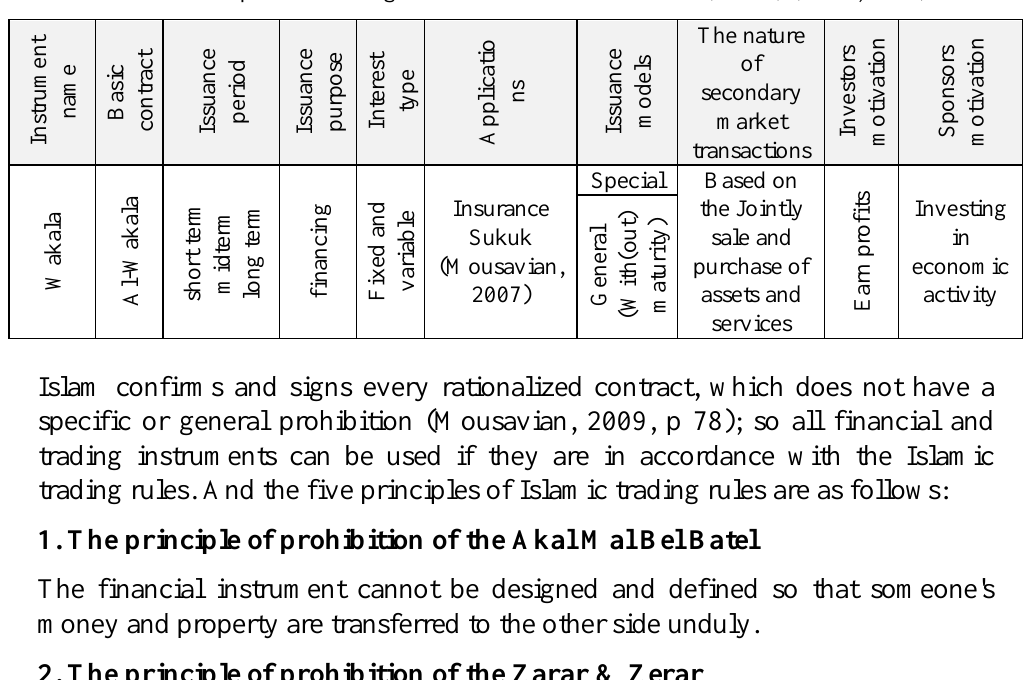
Table 1. Jurisprudence Categorization of Islamic Securities (Sukuk) (RDIS,